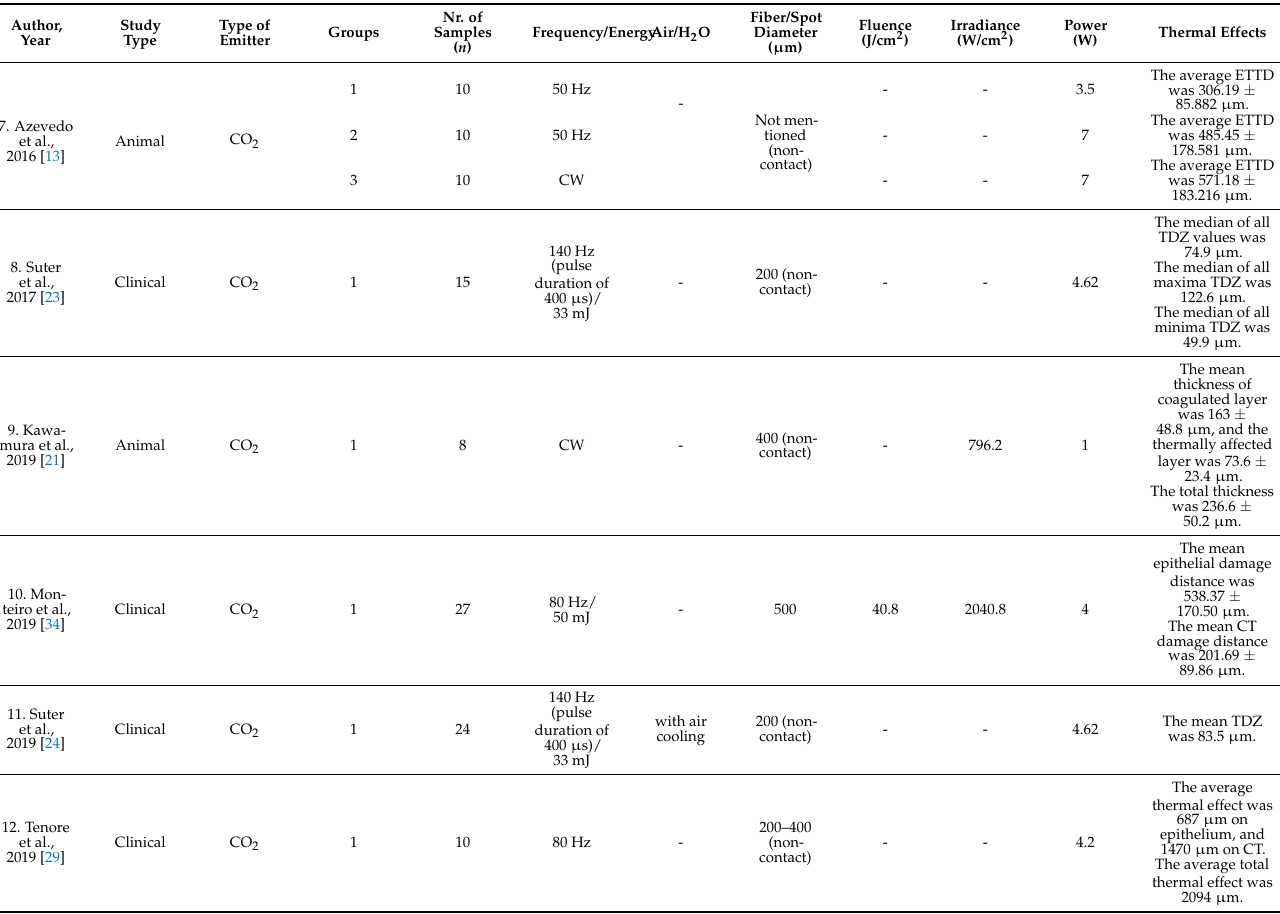
was236.6 ± 50.2 µ